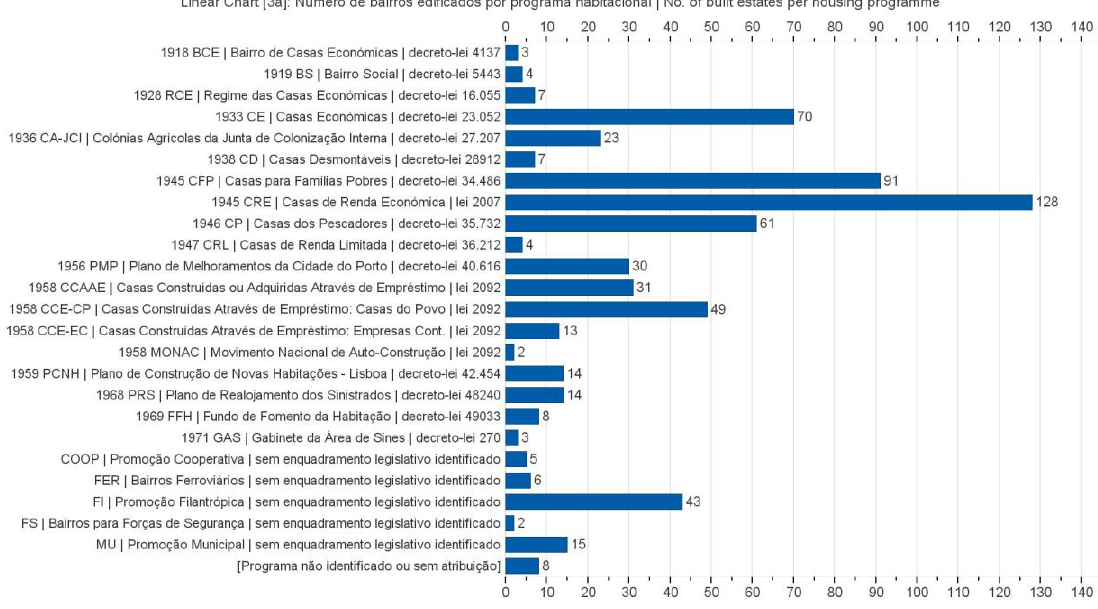
18 of 23 Figure A5. Linear chart. No. of built dwellings per housing programme. Source: MdH database, 2019. Universe: built